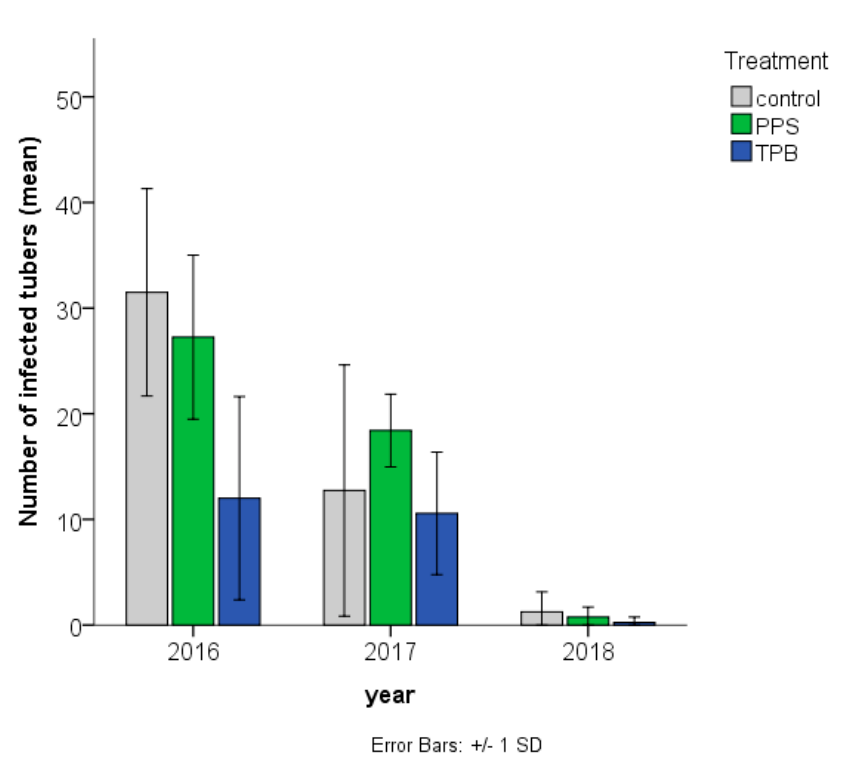
Figure 4. Number of Rhizoctonia sp. infected potato tubers in samples in the three different treatments in three consecutive years. Treatments: PPS contains Pseudomonas protegens , Pseudomonas jessenii , and Stenotrophomonas maltophilia ; TPB contains Trichoderma atroviride , Pseudomonas putida , and Bacillus subtilis . The horizontal (X) axis shows the study years, while on the vertical (Y) axis, the number of symptoms (means + standard deviation) are shown in each group, n = 4.